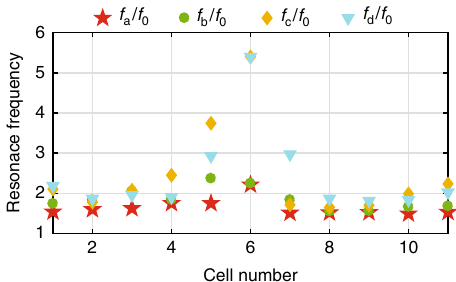
Fig. 4 Normalized resonance frequency of the individual resonators of the scattering-free anomalous refractive metasurface designes for θ i = 0° and = 60°. All the resonators are working out of the resonant frequency to θ t avoid